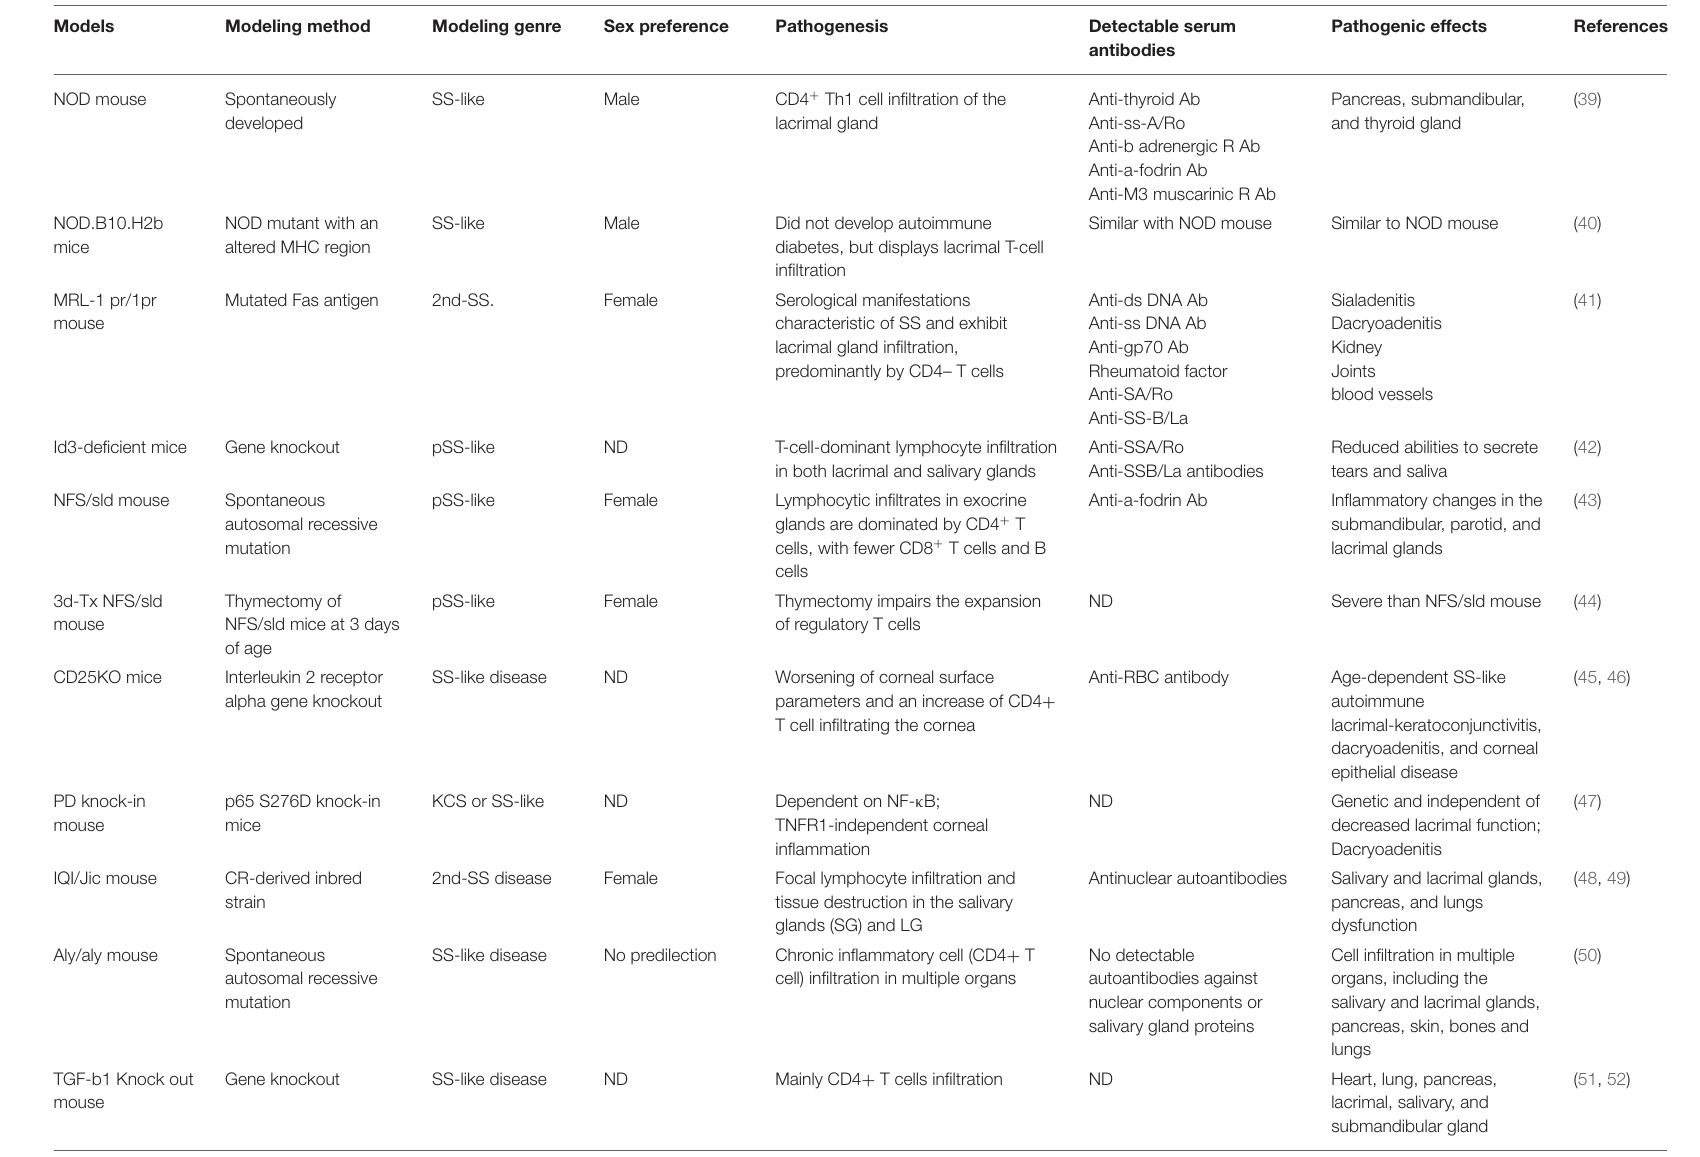
TABLE 1 | Autoimmune disease-associated dry eye